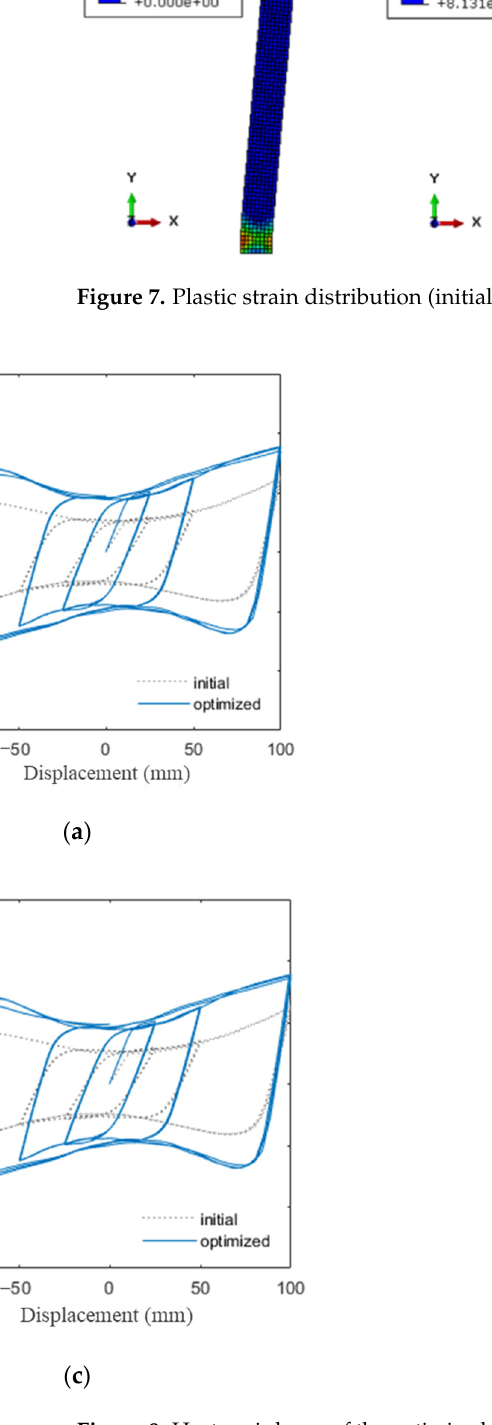
Table 1. Shape variable values, energy dissipation, and improvement of each optimized model with a fixed thickness.